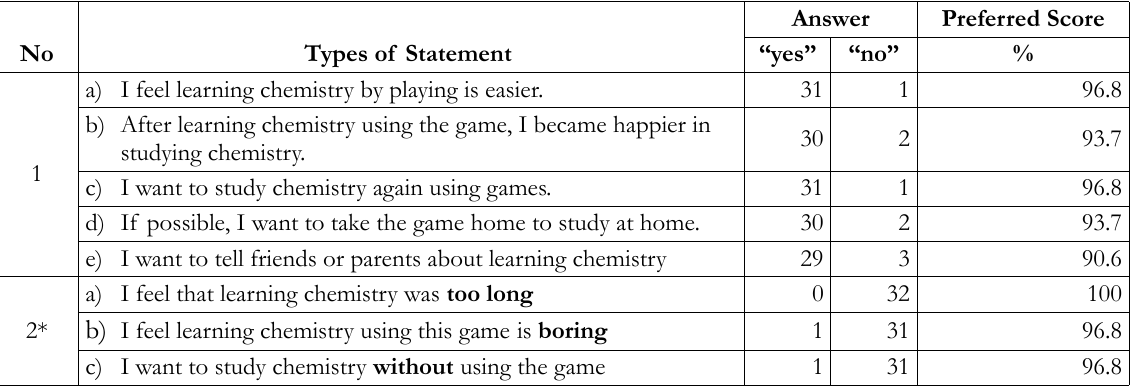
Table 4. Student questionnaire